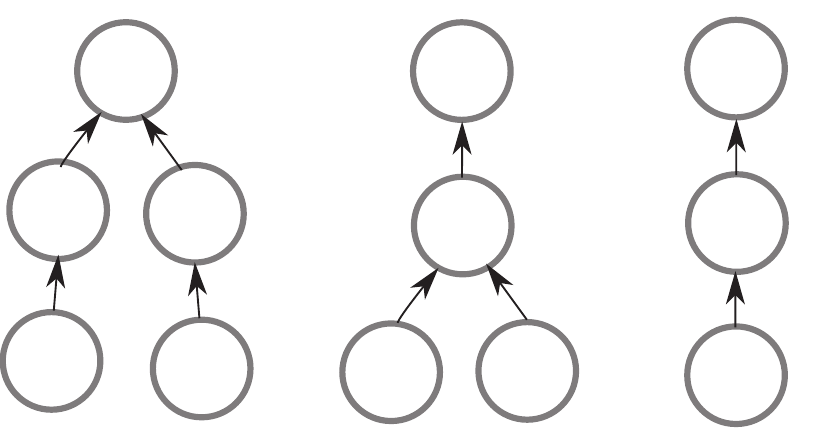
Fig 4. Condensation graphs of equilibrium networks. We depict the condensation graph of a network G containing three isolated hierarchical structures that are possible to result as a solution to a hierarchical network formation game with consensual agents (provided the adequate utility parameters exist). Notice that each isolated network has the topology of another possible equilibrium network for consensual agents, but not for non-consensual ones.